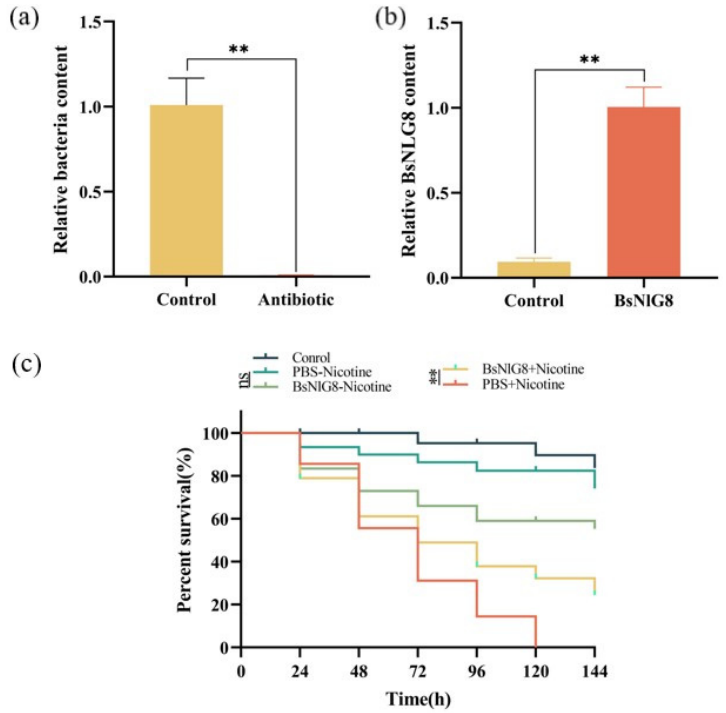
Figure 7. Effect of BsNLG8 treatment on BPHs ( a ) Relative abundance of symbiotic bacteria in BPHs after antibiotic treatment. ( b ) Relative abundance of BsNLG8 in BPHs after injection. ( c ) Survival curve of BPHs fed on nicotine after injection of BsNLG8. “-Nicotine”are not treated with nicotine, “+Nicotine” indicates nicotine treatment. “**” showed significant differences at p < 0.01.